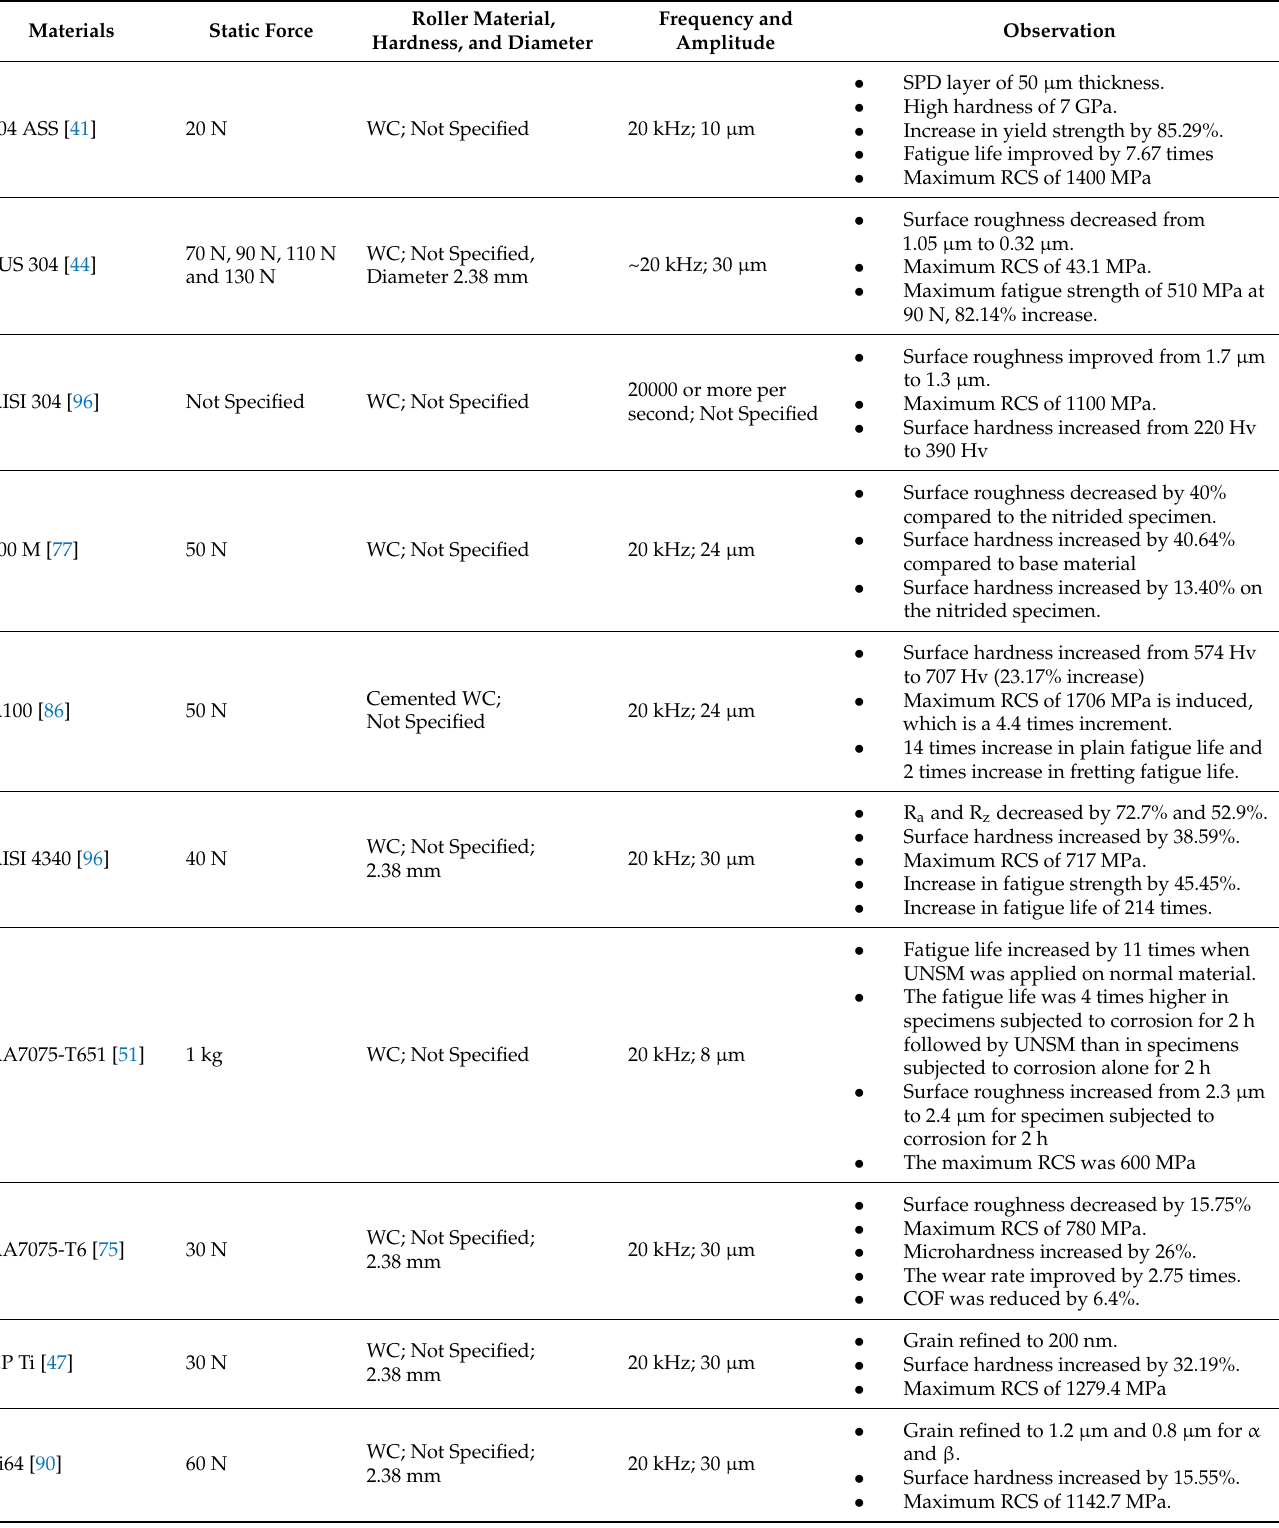
Table 1. Mechanical properties and microstructural features of USNM-treated substrate